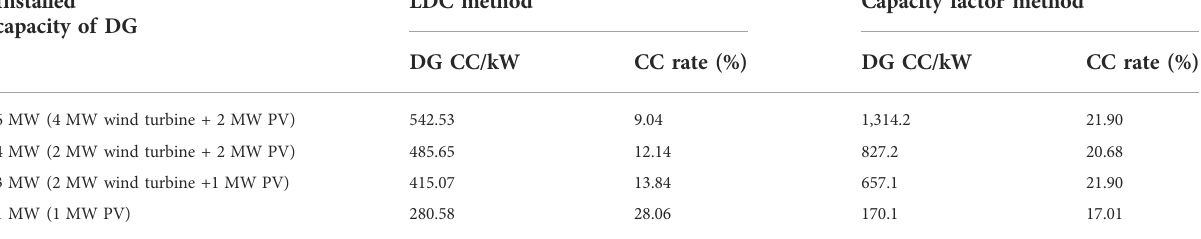
TABLE 4 DG CC evaluation results by using different methods. Installed capacity of